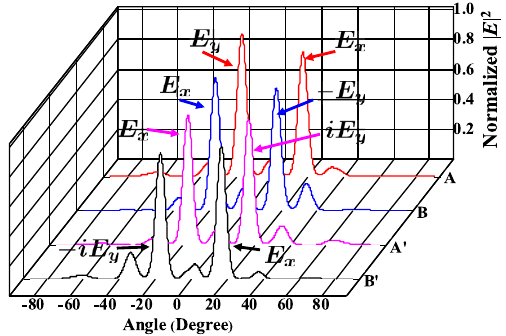
pixels with supercells  ,  ,  ′ , and  ′ , as shown in Figure 3(f)–(i).